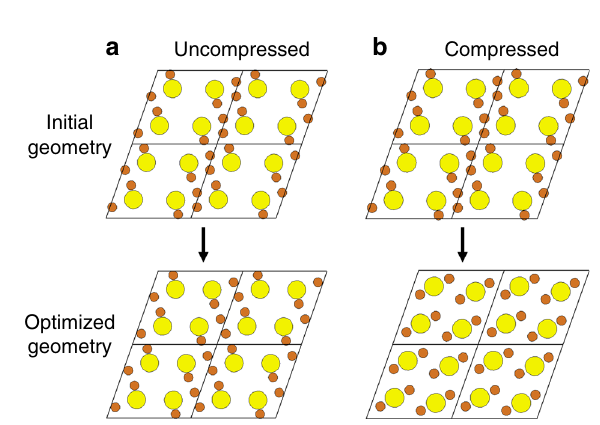
Fig. 4 DFT investigation of the correlation between lattice strain and cation disorder. a In the absence of any strain, a Cu 8 Se 4 unit cell maintains its Cu- vacancy order upon geometry optimization. b In contrast, a Cu 8 Se 4 unit cell, subject to a 3.9% compressive strain, loses Cu-vacancy order upon geometry optimization. Se 2 − is shown in yellow and Cu + in orange. Note that 2 × 2 × 1 supercells are shown for easier visualization of the vacancy ordering. The black arrow signi fi es the geometry optimization procedure. The unit cell parameters for the two cases are described in the methods